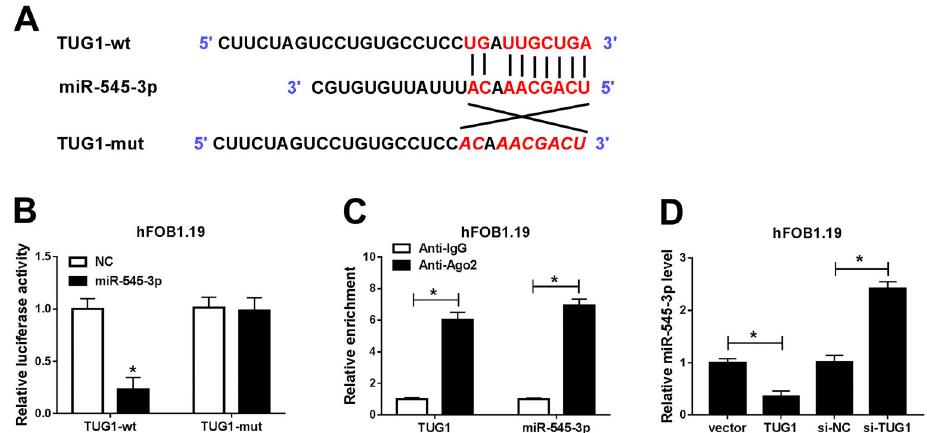
Figure 5. TUG1 directly targeted miR-545-3p. A , The predicted binding sites between TUG1 and miR-545-3p are shown. B , Luciferase activity was detected in hFOB1.19 cells co-transfected with TUG1-wt (wild type) or TUG1-mut (mutated) and miR-545-3p or negative control (NC). C , RIP assay was used to measure the enrichment of TUG1 and miR-545-3p in the immunoprecipitation complex. D , Expression of miR-545-3p was examined in hFOB1.19 cells transfected with vector, TUG1, si-NC, or si-TUG1. Data are reported as means ± SD of three independent experiments. *P o 0.05 ( t -test).